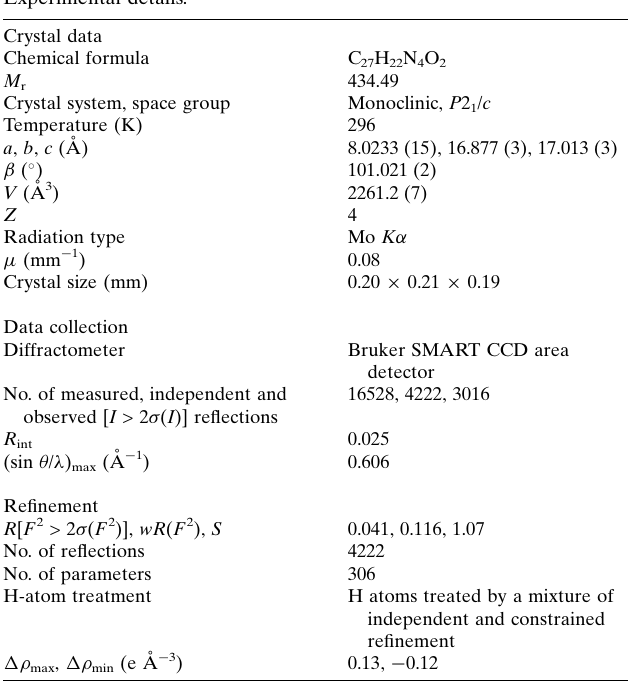
Table 2 Experimental details. Crystal data Chemical formula